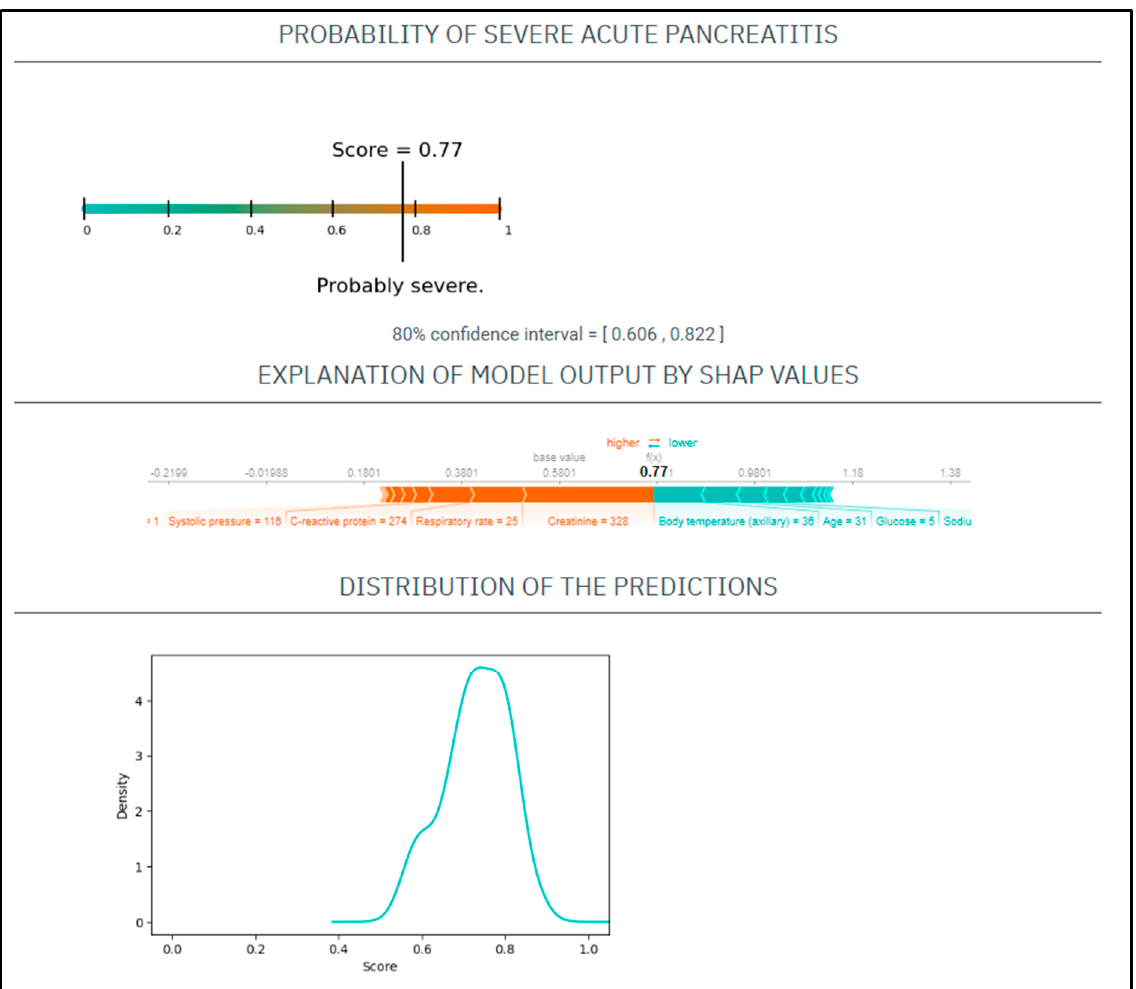
Figure 3. The EASY-APP-s prediction model for the patient in case number three.